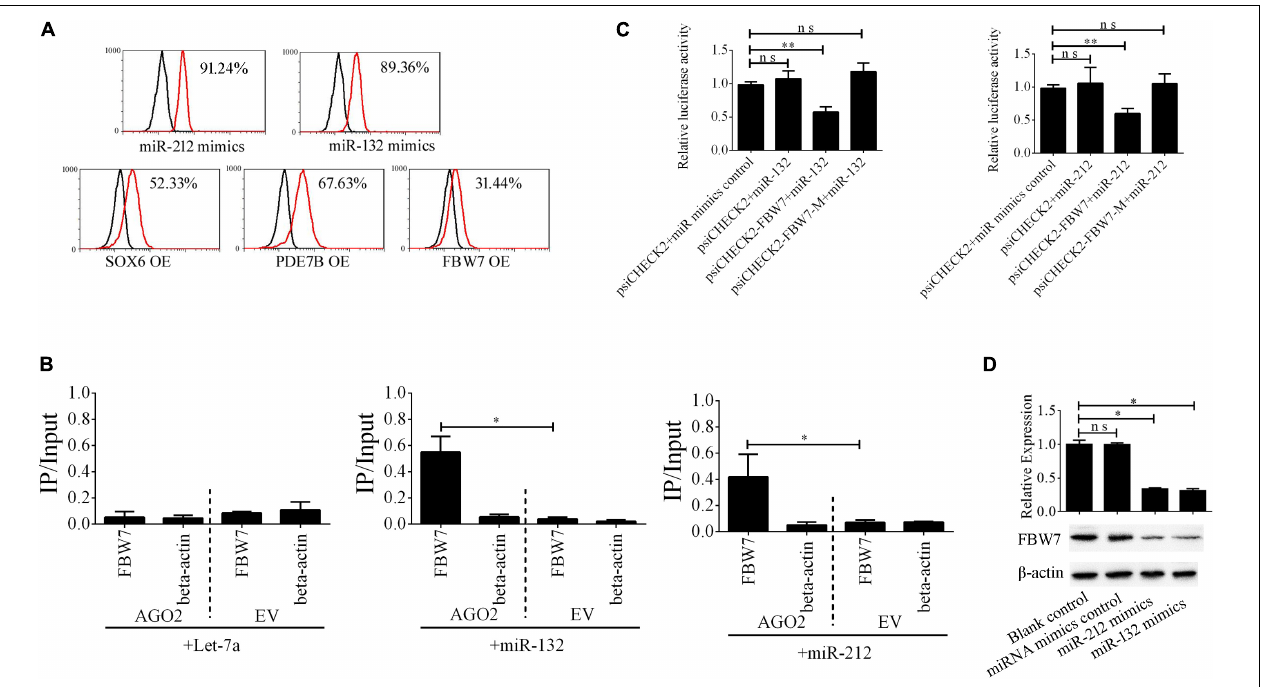
FIGURE 6 | EV-miR-212/132 target FBW7 to increase formation of i-Beta cells from iPSCs. (A) Flow cytometric analysis of insulin-positive cells after overexpression of miR-212/132 or its targets in differentiated iPSCs in stage IV at day 7. The number of insulin-positive cells was significantly changed after overexpression of miR-212/132 mimics or FBW7, but not SOX6 or PDE7B, in stage IV at 7 day. OE, overexpression. (B) Immunoprecipitation of Myc-tagged AGO2 from iPSCs cotransfected with Myc-AGO2 and either miR-212/132 or Let-7a (negative control). The empty vector (EV) served as the Myc-AGO2-related negative control. FBW7 and β -actin mRNA levels were quantified by qPCR and relative immunoprecipitate (IP)/input (total RNA) values were plotted. The results showed that miR-212/132 facilitated AGO2 association with FBW7. (C) The effect of miR-212/132 on FBW7 expression was validated using luciferase reporter assays. HEK293T cells were cotransfected with miR-212/132 mimics and a luciferase reporter vector. The vector contained either the wildtype (WT) miR-212/132-binding 3 (cid:48) UTR region of FBW7 or a mutated (MUT) 3 (cid:48) UTR region. Mutating the miR-212/132 target site in the 3 (cid:48) UTR of FBW7 abolished the inhibition of luciferase activity by miR-212/132. Relative luciferase activity and qPCR values represent the mean ± SD of at least three replicates. (D) Western blot analysis of FBW7 in iPSCs following overexpression of miR-212/132. Overexpression of miR-212/132 inhibited endogenous expression of FBW7. β -Actin was used as an endogenous control. Values represent the mean ± SD of at least three replicates. * p < 0 . 05, ** p < 0 .